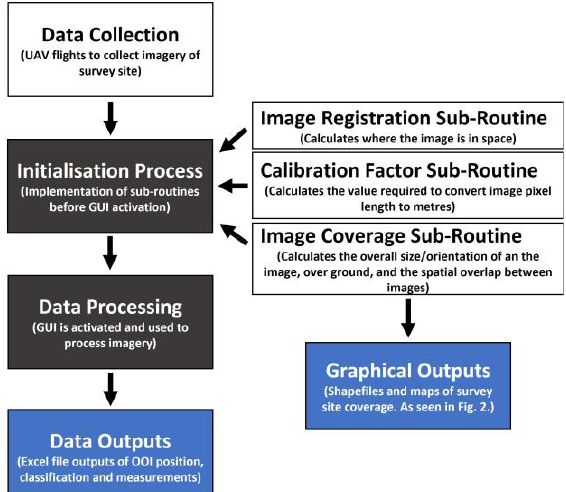
Fig. 3. The complete workflow of imagery collection and GUI usage, detailing the inputs (white), processes (black) and outputs (blue).